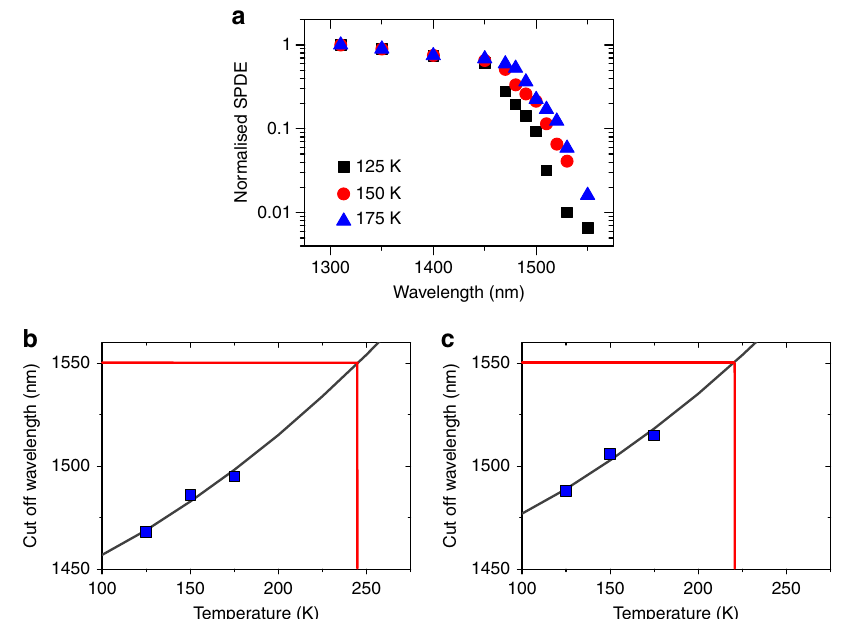
Fig. 5 Single-photon detection ef fi ciency (SPDE) as a function of wavelength. a Normalised SPDE as a function of incident wavelength for a 100 µ m single- photon avalanche diode (SPAD) at temperatures of 125 K (black squares), 150 K (red circles) and 175 K (blue triangles). b Experimental (squares) and theoretical (line) Ge cut-off wavelength as a function of temperature. c Estimated cut-off wavelength and fi tting for a Ge-on-Si SPAD with a 2- µ m-thick Ge absorption region. The red lines in b and c indicate the temperature required to reach a cut-off wavelength of 1550